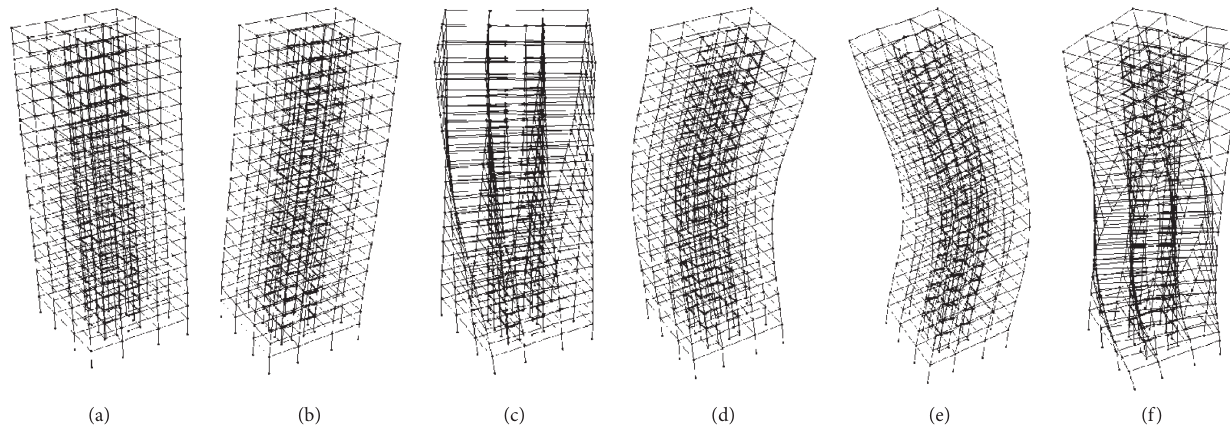
Figure 11: The first 6 modes of the structure. (a) 1st mode. (b) 2nd mode. (c) 3rd mode. (d) 4th mode. (e) 5th mode. (f) 6th